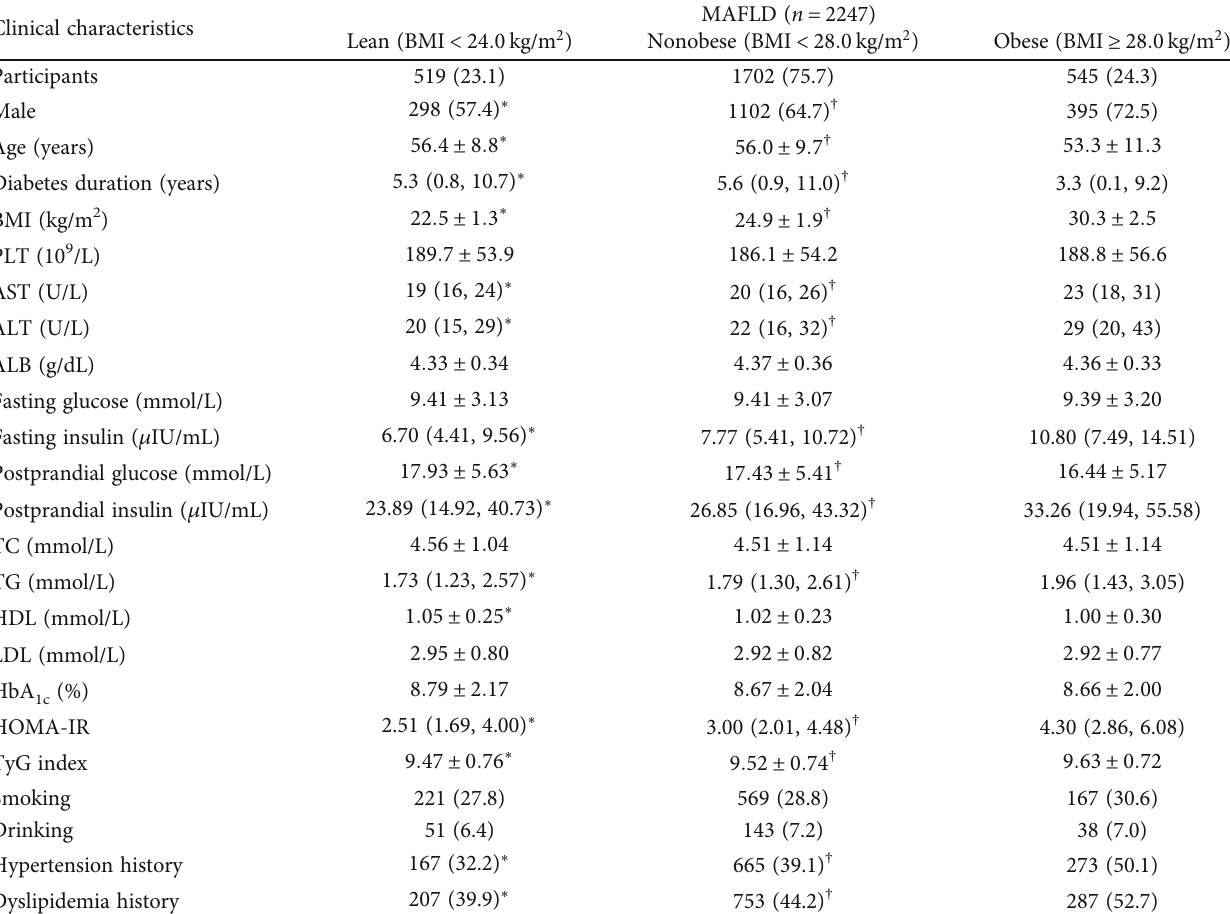
Table 2: Clinical characteristics in di ff erent MAFLD categories strati fi ed by BMI. Clinical